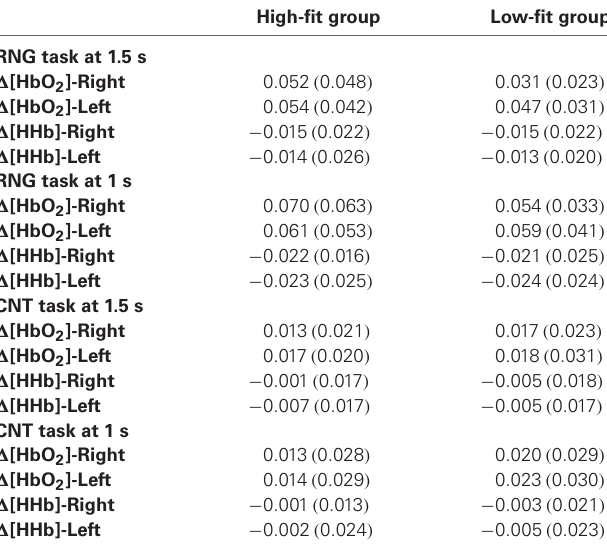
Table 3 | Mean (SD) of ∆ [HbO 2 ] and ∆ [HHb] slope coefficients in µ M.cm/s as a function of task, pace, and hemisphere for the high-fit and low-fit groups